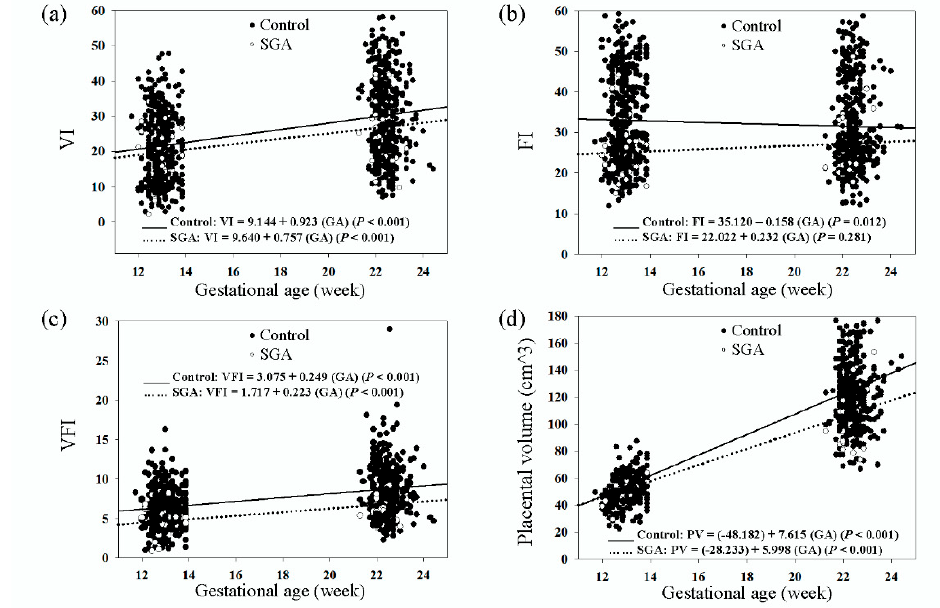
Figure 4. Generalized estimating equation analyses of ( a ) VI, ( b ) FI, ( c ) VFI, and ( d ) placental volume during the first and second trimesters in the SGA ( ··· ) and control (—) groups. VI: vascularization index; FI: flow index; VFI: vascularization flow index; GA: gestational age; PV: placental volume.